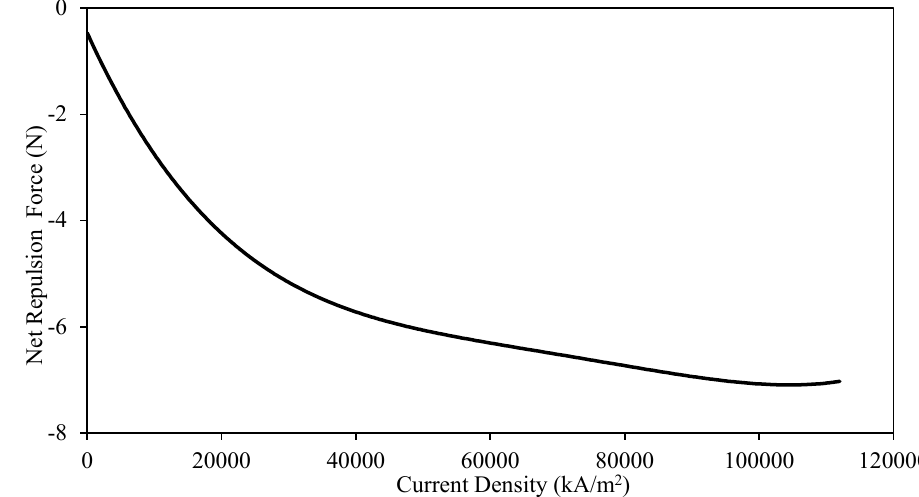
Figure 8. Net repulsion force on the permanent magnet at its zero-stroke position versus coil current density.